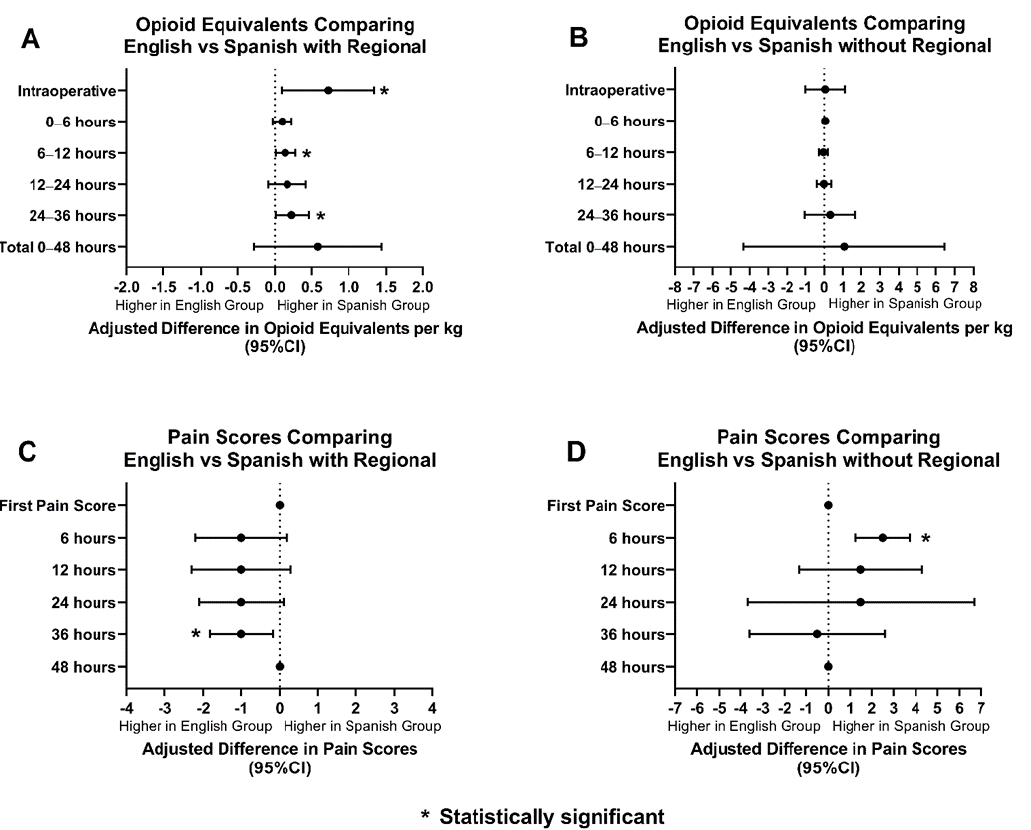
Figure 4. Opioid equivalents and pain score comparisons amongst ES and SS patients with and without regional anesthesia. ( A ): Adjusted difference in opioid equivalents per kg vs time in English vs Spanish patients with regional anesthesia; ( B ): Adjusted difference in opioid equivalents per kg vs time in English vs Spanish patients without regional anesthesia; ( C ): Adjusted difference in pain score vs time in English vs Spanish patients with regional anesthesia; ( D ): Adjusted difference pain score vs time in English vs Spanish patients without regional anesthesia.